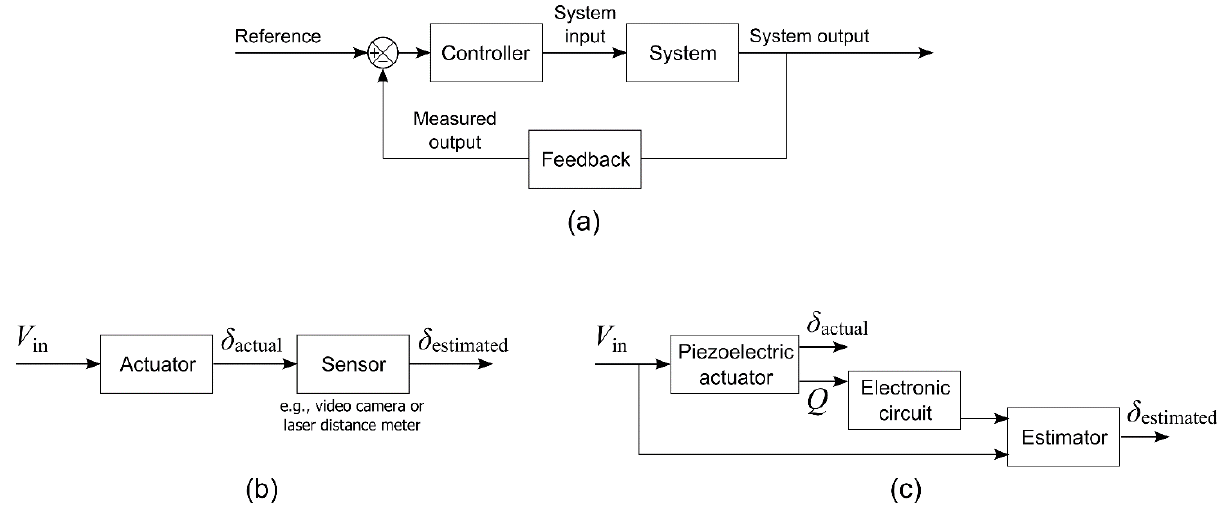
Figure 2. ( a ) Description of a closed-loop control system; ( b ) conventional sensor-based systems for estimating displacement δ of an actuator; ( c ) example of self-sensing estimation of displacement δ based on the charge Q of a piezoelectric actuator (subplot (c) adapted and redrawn from